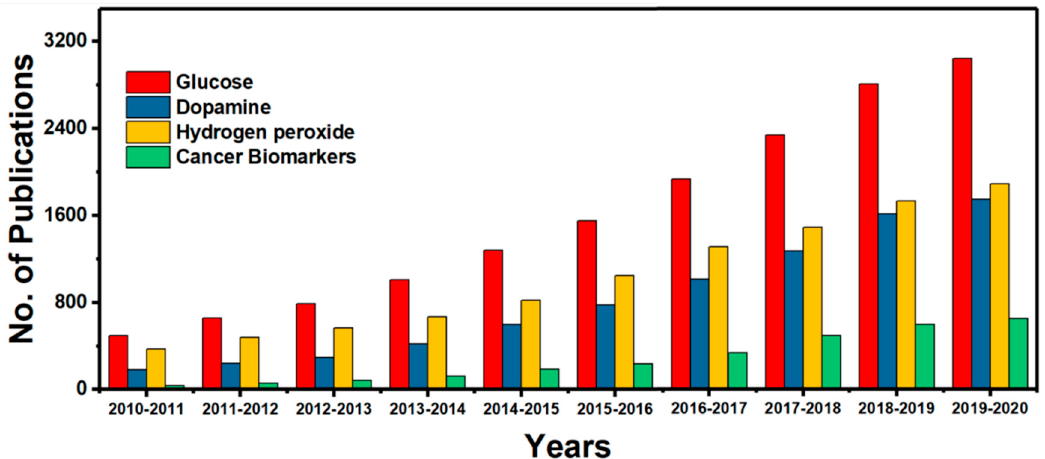
Figure 13. The trend in ECB research over the last decade. The statistical data were obtained from Google Scholar search engine using the following keywords in advance search mode: metal nanoparticle + “glucose” / ”dopamine” / ”hydrogen peroxide” / ”cancer biomarker” + “electrochemical biosensor” for the respective